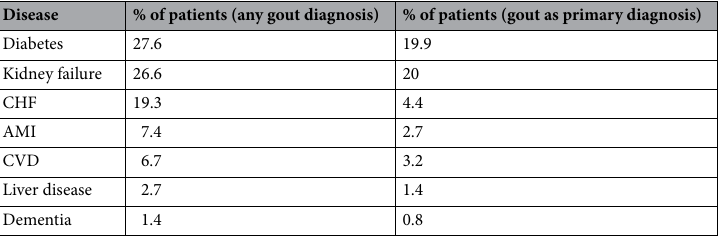
Table 2. Comorbidities associated in gout as main diagnosis and gout as any diagnosis. CHF congestive heart failure, AMI acute myocardial infarction, CVD cerebrovascular disease.